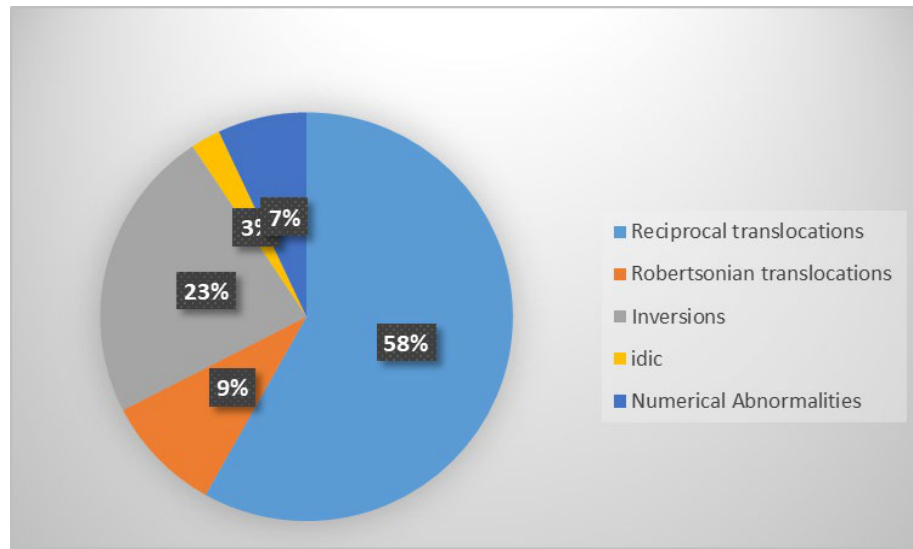
Fig 2. Pie chart for the percentage of different abnormalities observed in this